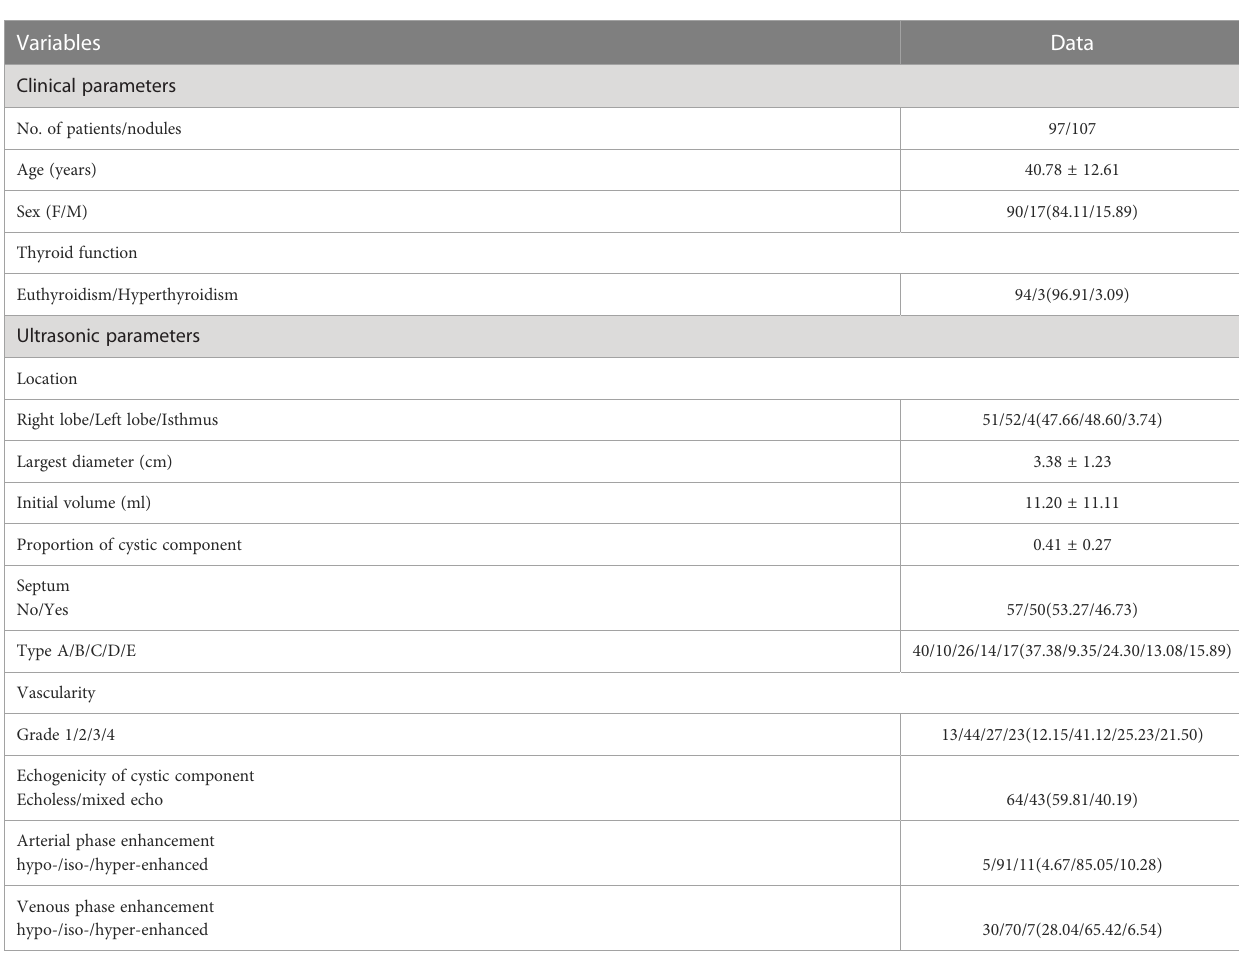
TABLE 1 The basic and ultrasound